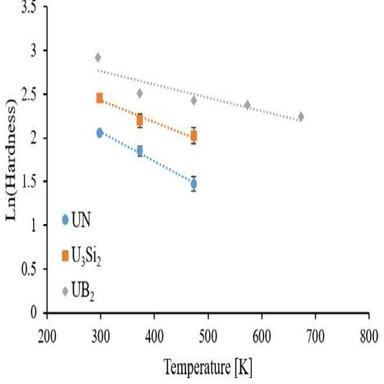
The ln(Hardness) versus temperature for the UN, U3Si2, and UB2.